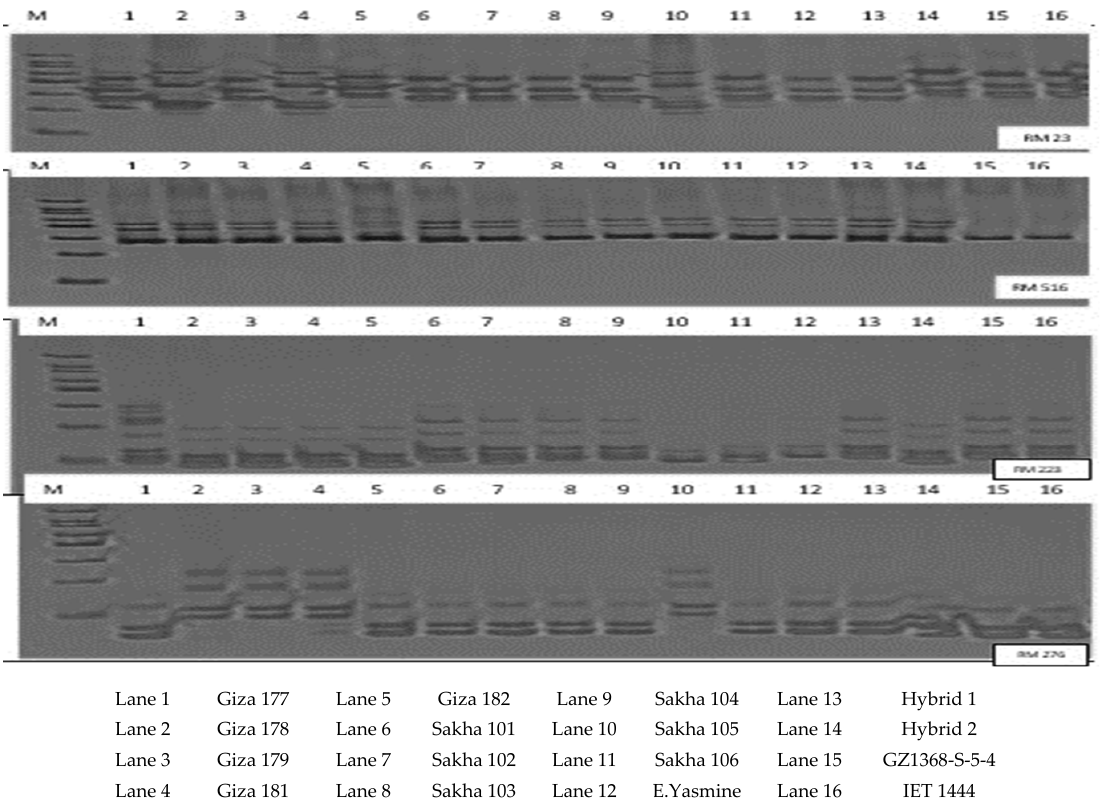
Figure 1. Agarose gel electrophoresis of PCR amplified fragments for the polymorphic SSR markers RM23, RM518, RM223, and RM276. M is a 100 bp DNA ladder.